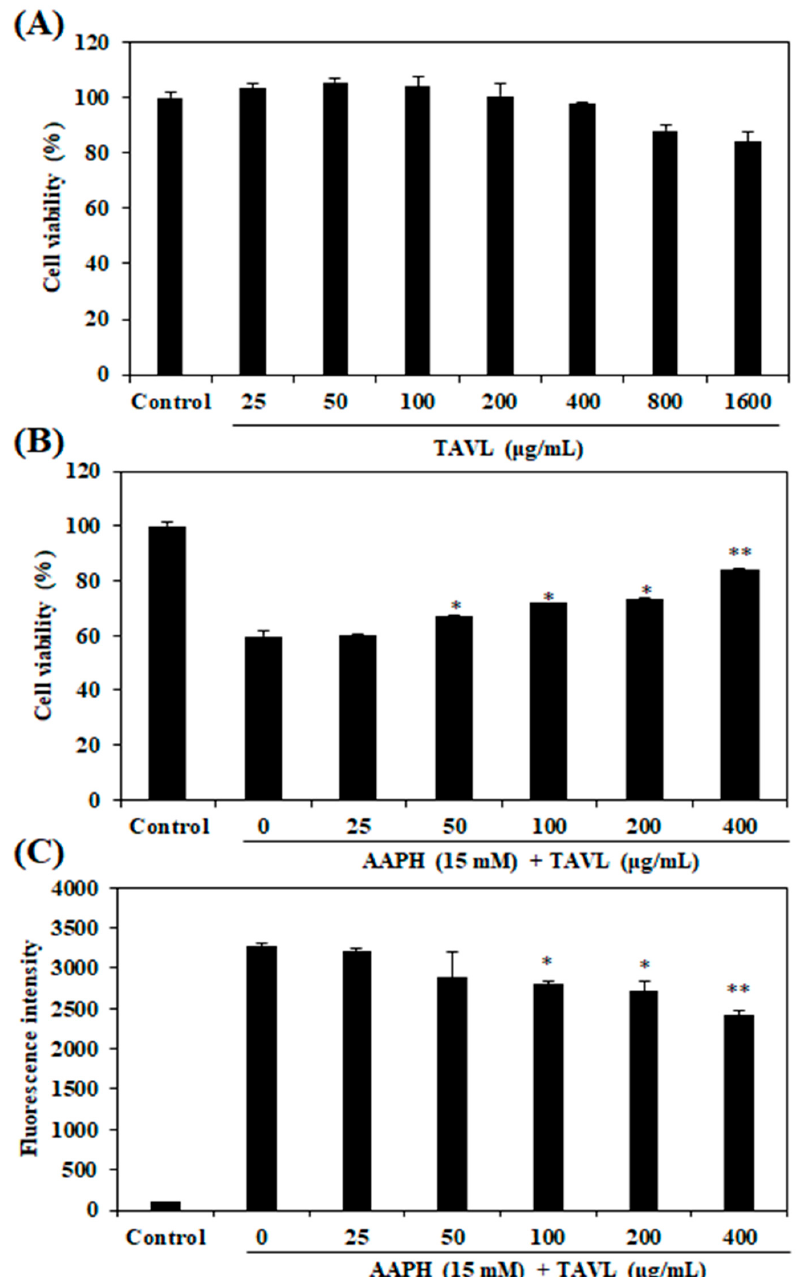
Figure 2. Protective e ff ects of purified peptide (TAVL) against 2,2-Azobis-(2-amidinopropane) dihydrochloride (AAPH)-induced oxidative stress in Chang liver cells. Cells were treated with TAVL at indicated concentrations. ( A ) Cytotoxic e ff ect of TAVL on viability of normal cells. After 24 of treatment with TAVL, cell viabilities were assessed by MTT assay. ( B ) E ff ect of TAVL on cell viability of AAPH-treated Chang liver cells. Cell viabilities were assessed by MTT assay. ( C ) E ff ect of TAVL on intracellular ROS generation in AAPH-treated Chang liver cells. Intracellular ROS generated was detected by 2 (cid:48) ,7 (cid:48) -dichlorodihydrofluorescein diacetae (DCFH-DA) assay. Values are expressed as mean ± S.E. from triplicate experiments. Significant di ff erences from only AAPH-treated group (positive control) were identified at * p < 0.05, ** p < 0.01 as analyzed by Duncan’s multiple range test. The control group represents the negative control that does not receive treatment of AAPH and sample in an